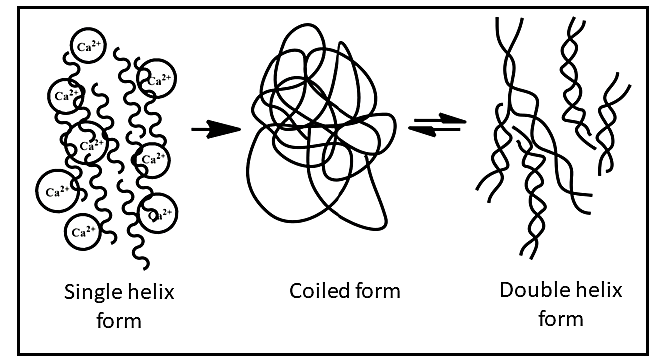
Figure 2. The conformational changes in xanthan gum.